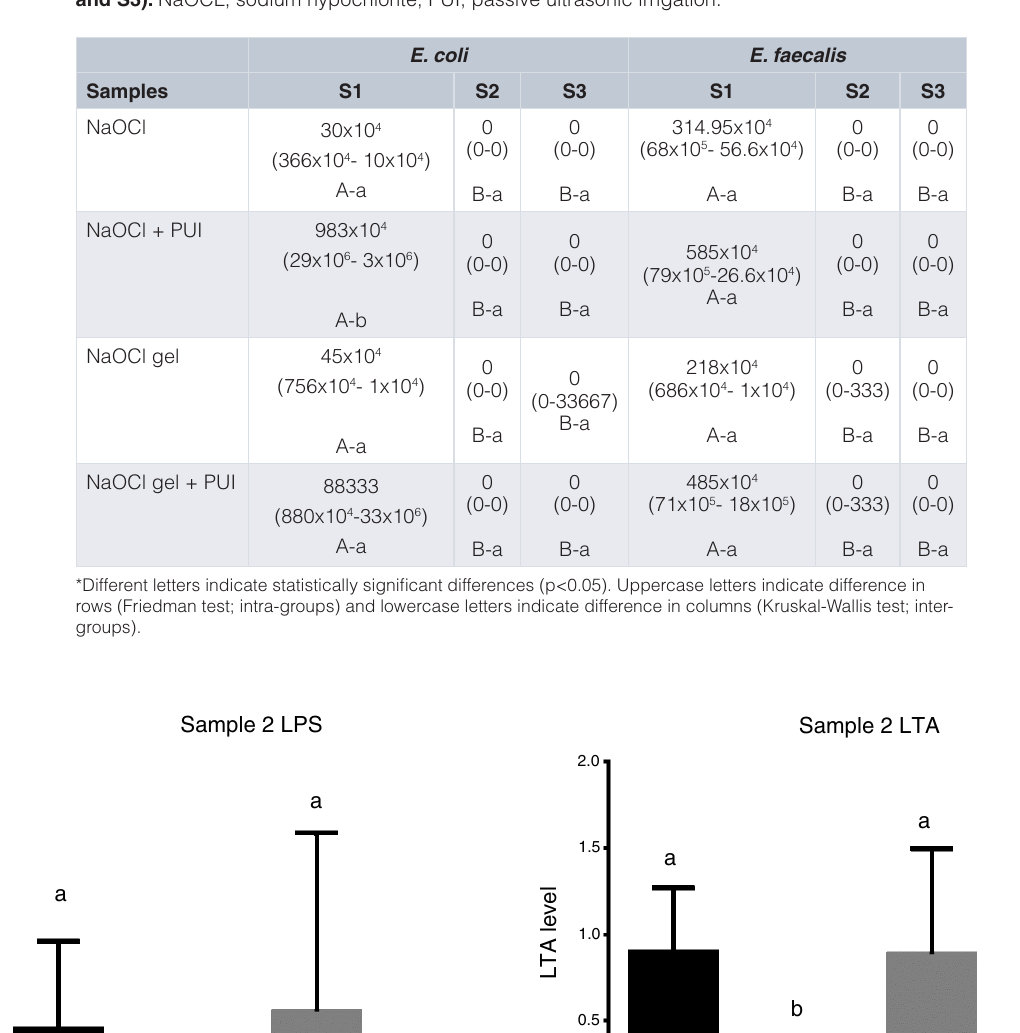
activity may be influenced by the irrigation protocol (irrigation time; irrigant volume; instrument shape and material; and the irrigation frequency and intensity) (van der Sluis et al ., 2007). In conclusion, our study showed that NaOCl gel has the same antimicrobial action of NaOCl solution and can partially detoxify endotoxins. PUI improves NaOCl (gel or solution) action over E. faecalis and E. coli formation and their endotoxins (LPS and